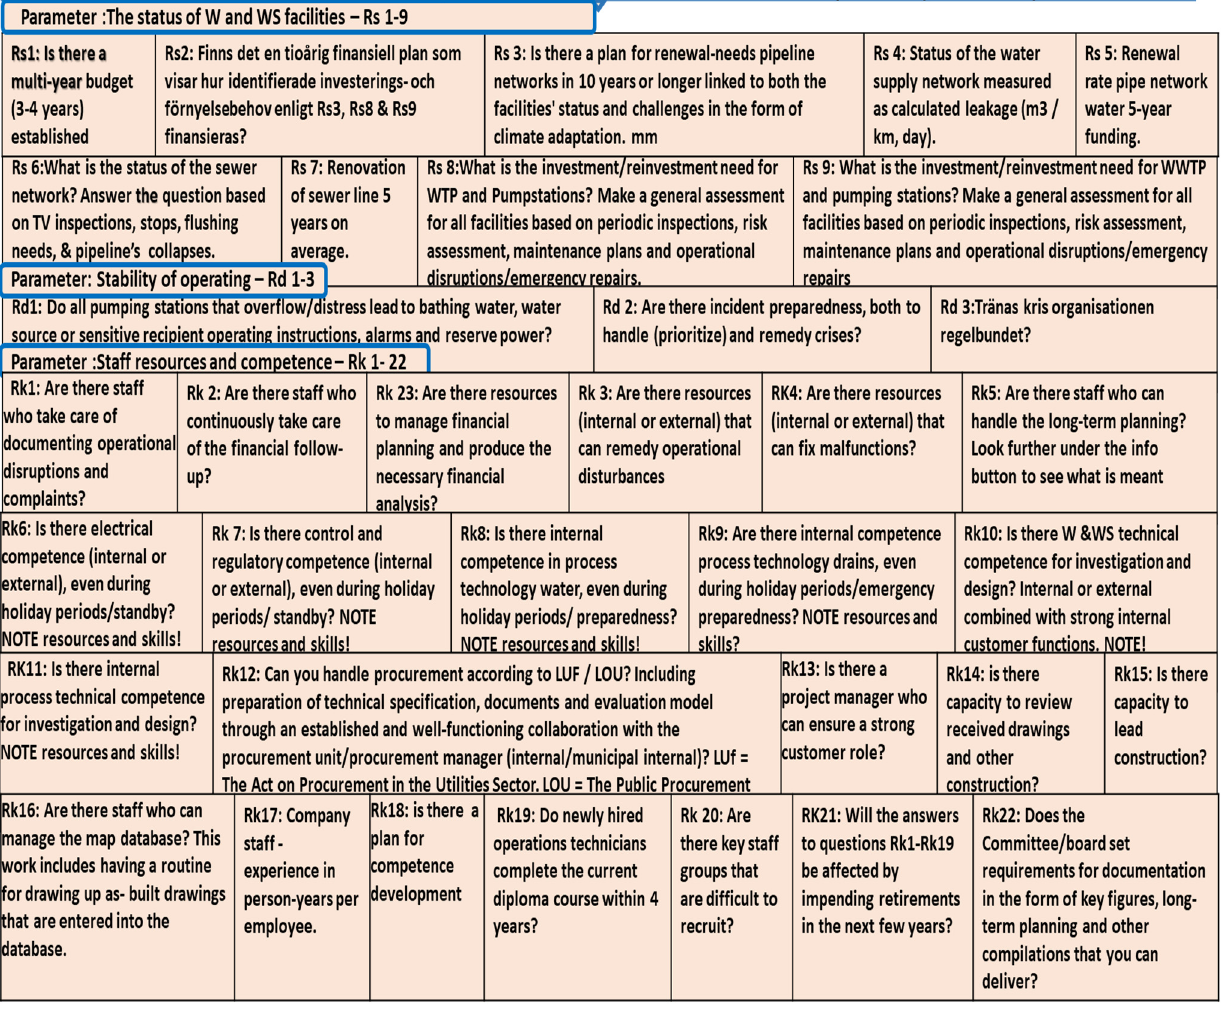
Figure A3. “Sustainable resources” pillar, three related parameters, group codes for parameters, and related questions (key figures).